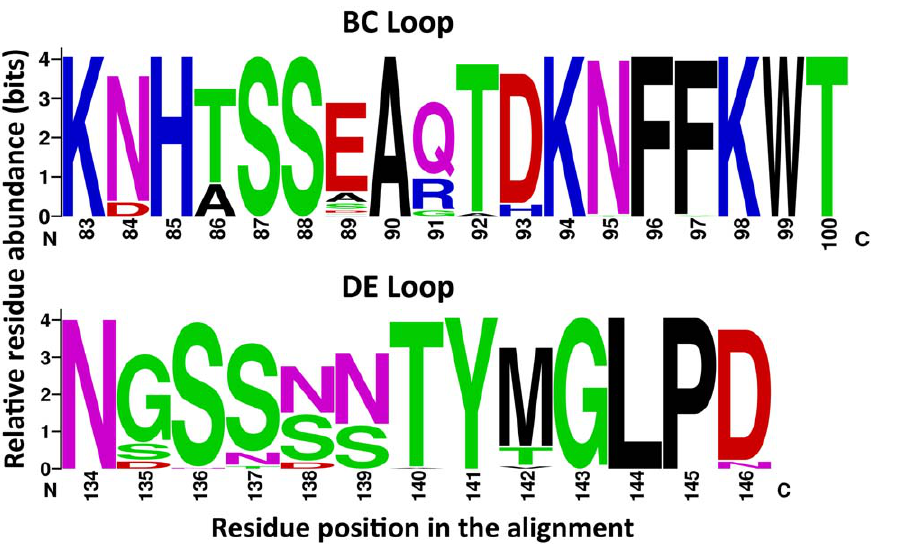
Figure 6. Relative residue abundance at the alignment positions of BC and DE surface-exposed loops. The graphical representation was generated using WebLogo. The height of symbol indicates the relative frequency of the corresponding amino acid at that position. Residue positions are given based on the nucleotide positions of the Fermon strain (AY426531).